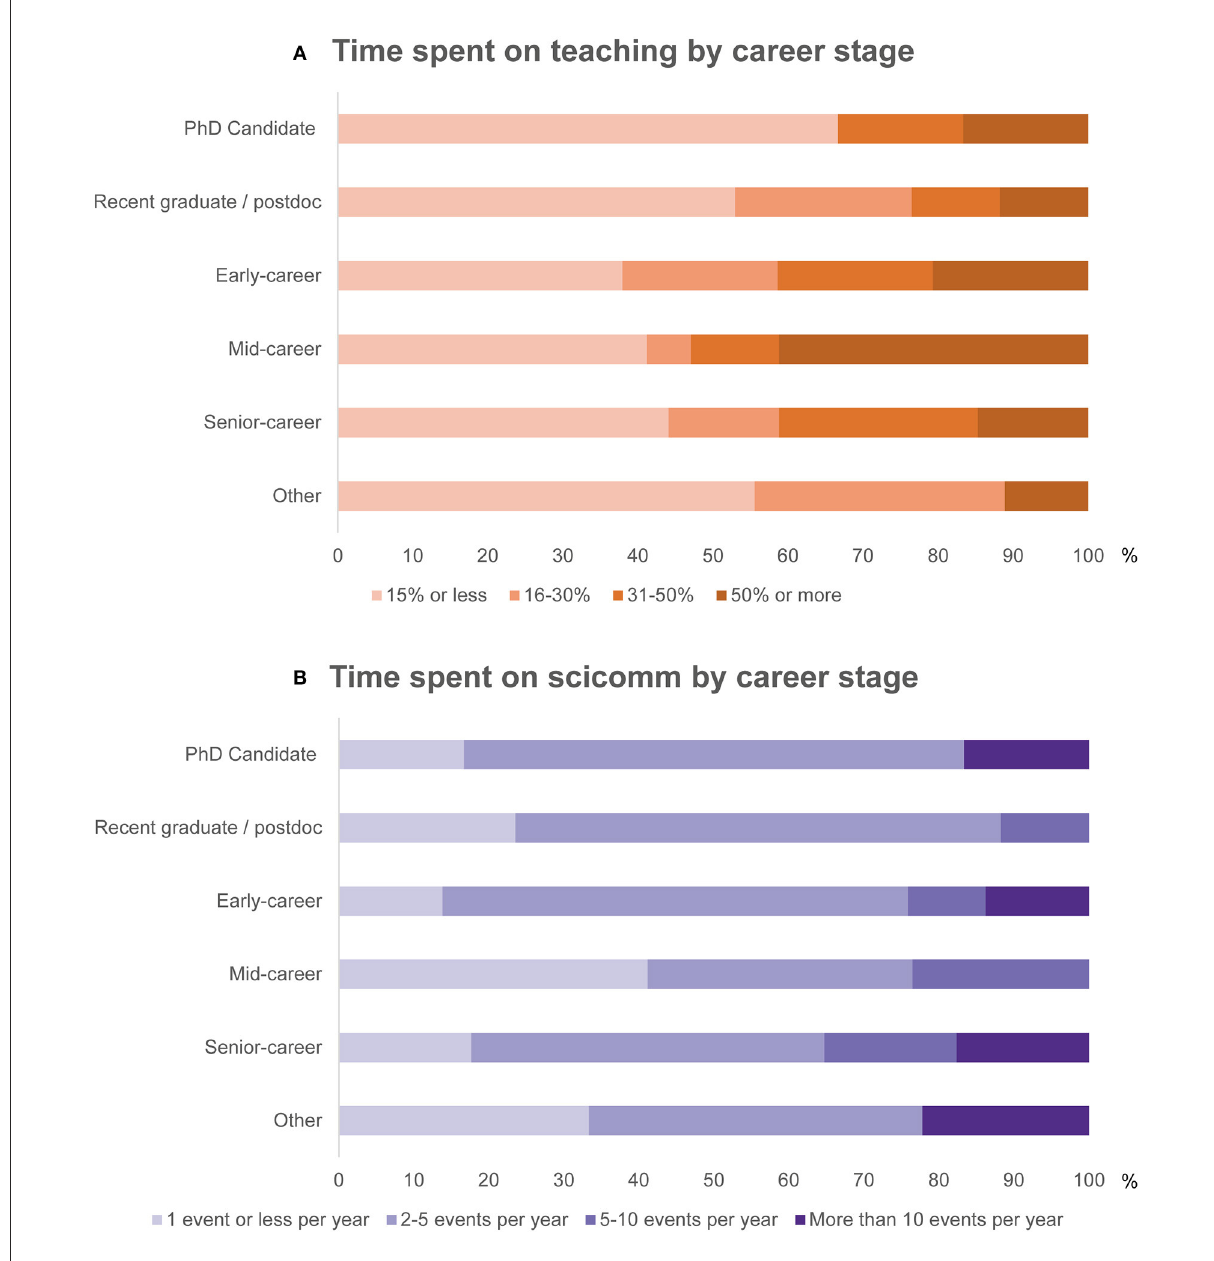
FIGURE4 How does a palaeoscientist’s career stage correlate with time spent on (A) teaching and (B) scicomm?